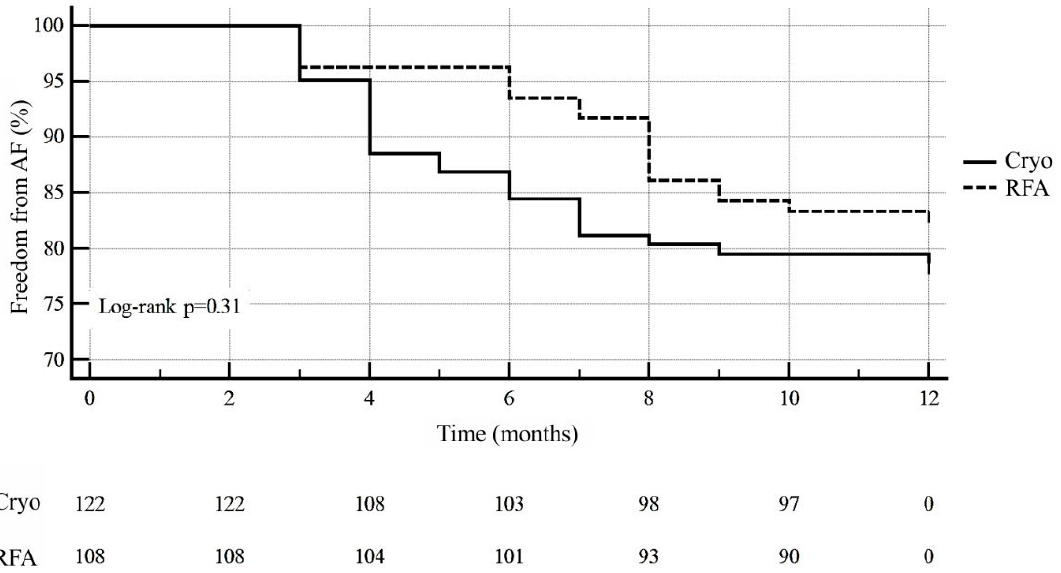
Figure 4. Freedom from AF in cryoballoon and radiofrequency PV’s isolation during 12 months of follow-up. Table 3. Characteristics of cryoablation subgroups according to morphometry and cryokinetic data, Me (Lq; Uq), M ±